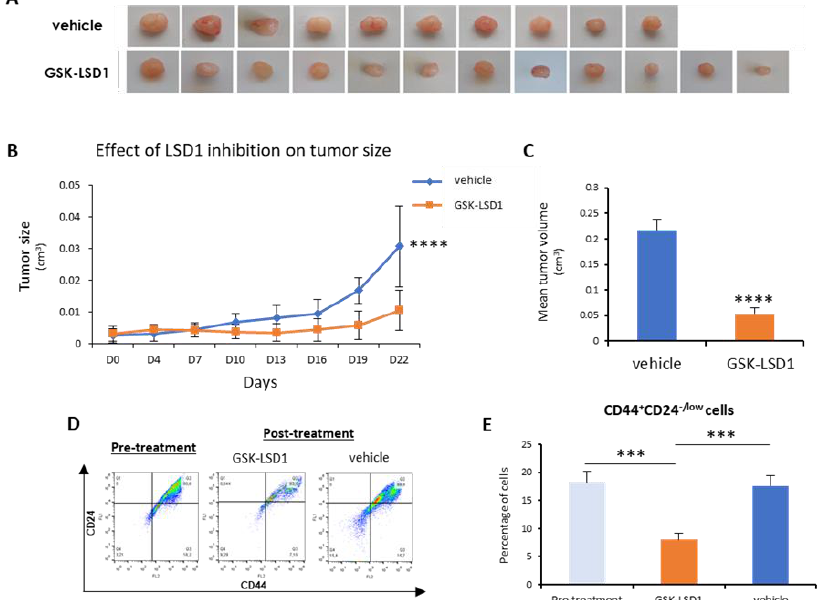
Figure 5. LSD1 inhibition reduced tumor growth and targeted the CSC subpopulation in vivo. MDA-MB 468 breast cancer cells were injected orthotopically in mice (into two fat pads / mouse). Treatment with the GSK-LSD1 inhibitor ( n = 6) or with the vehicle control ( n = 5) started when the tumors were detectable by palpation and lasted for 22 days, when the tumors were removed and measured. ( A ) Representative images of the tumors excised from mice treated with vehicle or GSK-LSD1 inhibitor. ( B ) Graphical representation of changes in tumor size over the course of the experiment. ( C ) Graphical representation of the e ff ects LSD1 inhibition on the mean tumor volume as measured at the end of the experiment. ( D ) The FACS analysis of dissociated tumor cells isolated pre-treatment or post-treatment with GSK-LSD1 or vehicle. Single cells were stained with antibodies against the CD44 and CD24 cell surface proteins. ( E ) Quantification of FACS analysis presented in ( D ). Error bars represent SEM. *** p < 0.001, **** p < 0.0001.